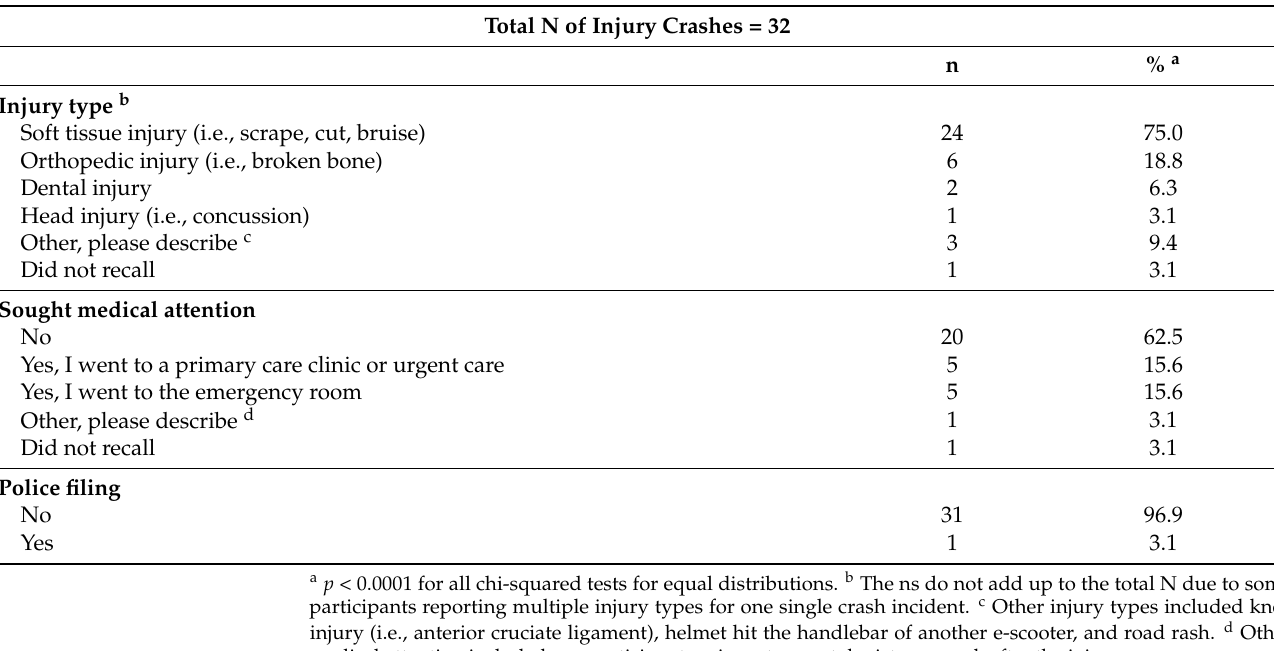
Table 4. Injury characteristics for e-scooter related injury crashes.